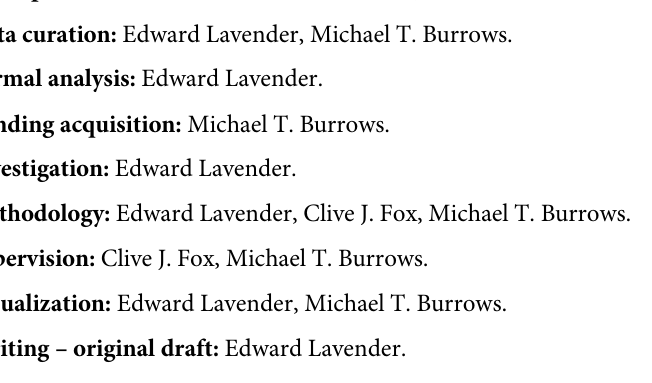
S9 Fig. The mean predicted change in the index of thermal habitat suitability, E( Δ CRCS under future sea bottom temperature (SBT) change for two climate experiments (RCP 4.5 and 8.5) over mid-century (M) and late-century (L) timescales. In each 0.5˚ grid cell, the mean predicted change in the CRCS, calculated across all species whose predicted distribu- tions overlap with that cell, is shown. Predictions are only shown within Exclusive Economic Zones. Adjacent to each map, the coloured line shows the mean E( Δ CRCS each latitudinal band, following same colour scheme as for the map, with lower values (in red) to the left and higher values (in green) to the right. Background coastline data are from Natural Earth (public domain). (TIF) S1 Table. A list of modelled species. Taxa are ordered by alphabetically by order, class, family and genus. For each species, the number of unique 0.5˚ cells with occurrence observa- tions used by Aquamaps to generate the species’ distribution is shown. Cell occurrence counts vary between 10–1015 (median = 58, mean = 96, standard deviation = 103) cells. The 10 th , 50 th and 90 th quantiles in baseline sea surface temperature across species’ distributions (rounded to two decimal places) are also provided.